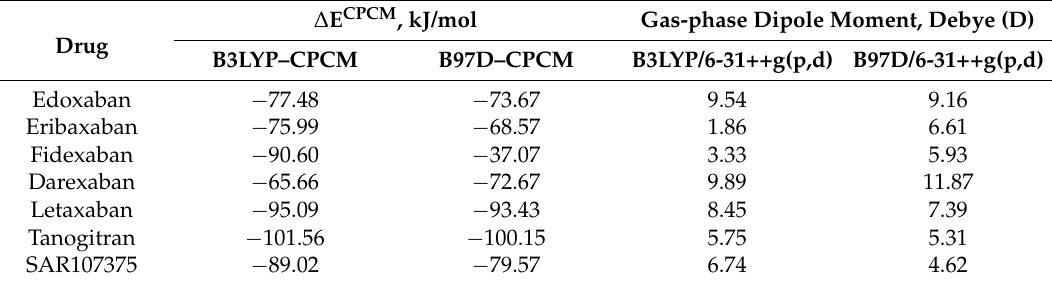
Table 2. The solvent stability (water) of the drugs studied.